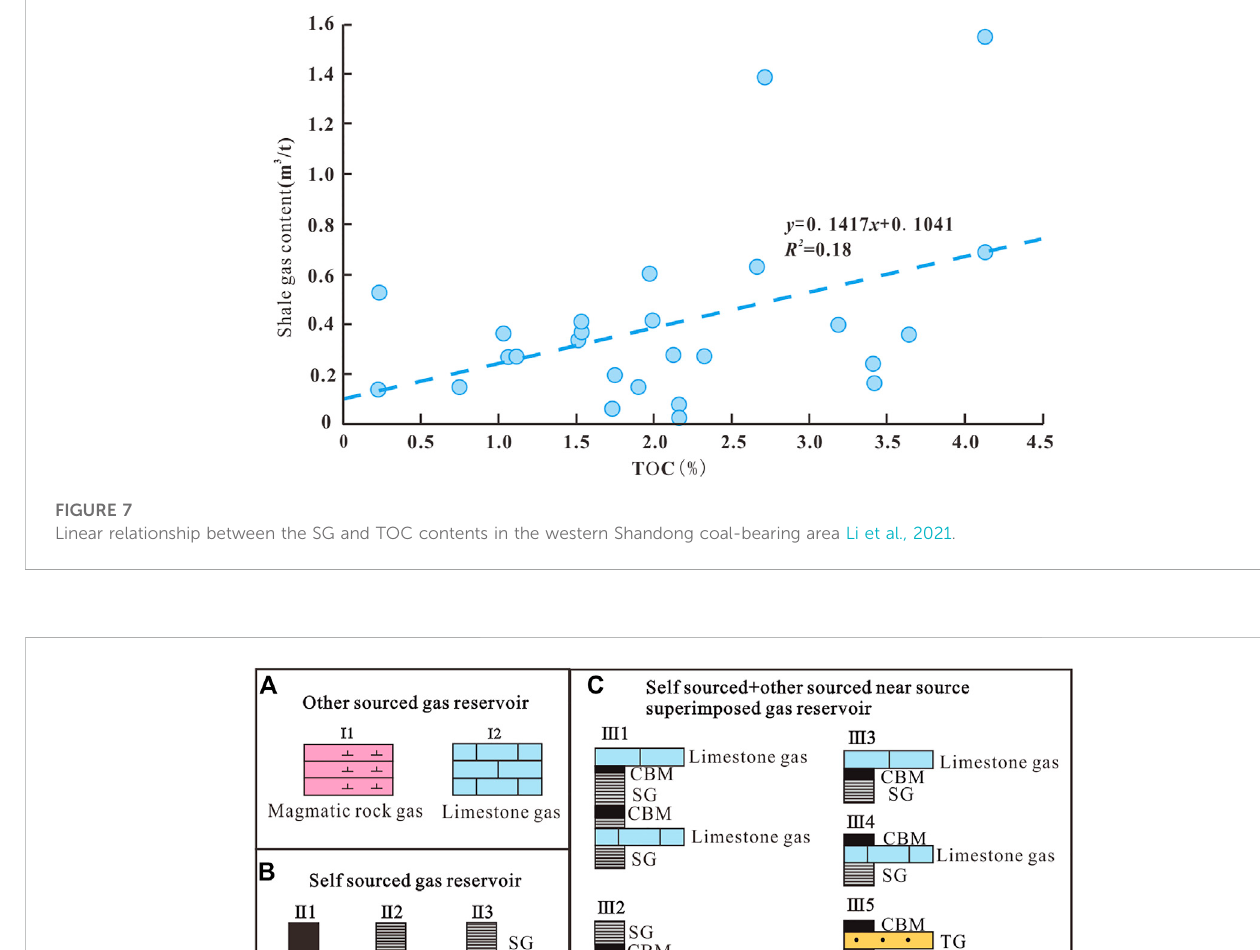
Frontiers in Earth